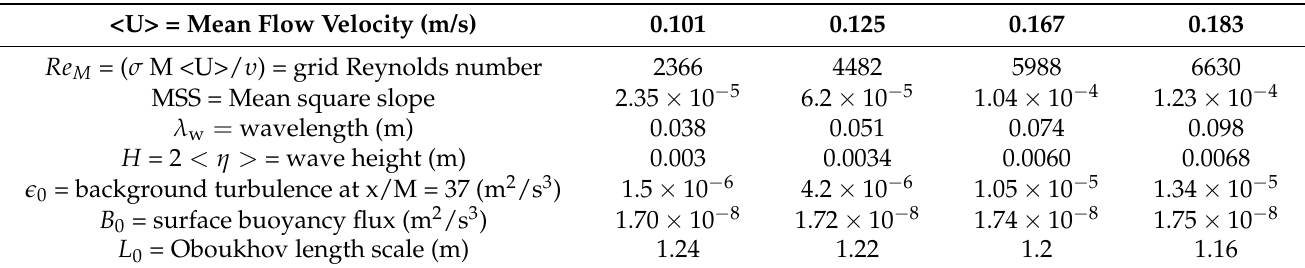
Figure 1. ( a ) A schematic of the Air–Sea Interaction Saltwater Tank (ASIST) tank at the University of Miami. Heated grid and grid-generated turbulence were installed at the tank entrance. The vertical microstructure profiler (VMP), laser slope, and current meter locations from turbulence generating grid are shown by x / M . The insets indicate a side view of the instrument’s vertical position at the tank with a freshwater level of 0.5 m and the turbulence generating grid’s mesh shape. ( b ) A schematic of internal and surface sources of turbulence. The blue arrows show the direction of the mean flow velocity. The swirl lines represent the background or internal turbulence generated by the grid. Table 1. The table indicates the summary of the